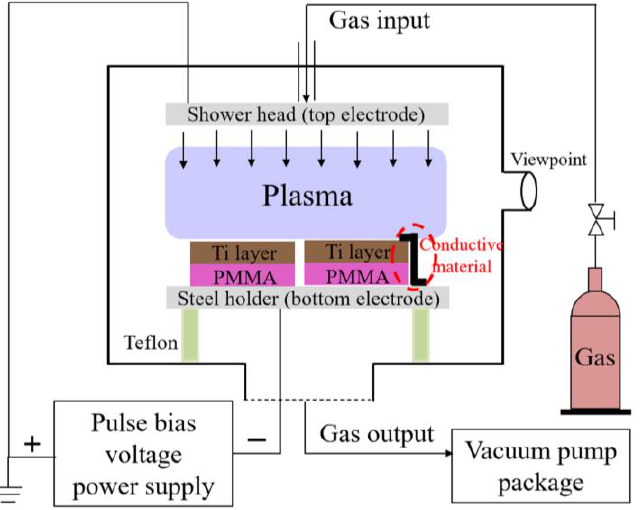
Figure 1. The schematic diagram of PECVD system for DLC films deposited on Ti/PMMA with and without conductive materials.